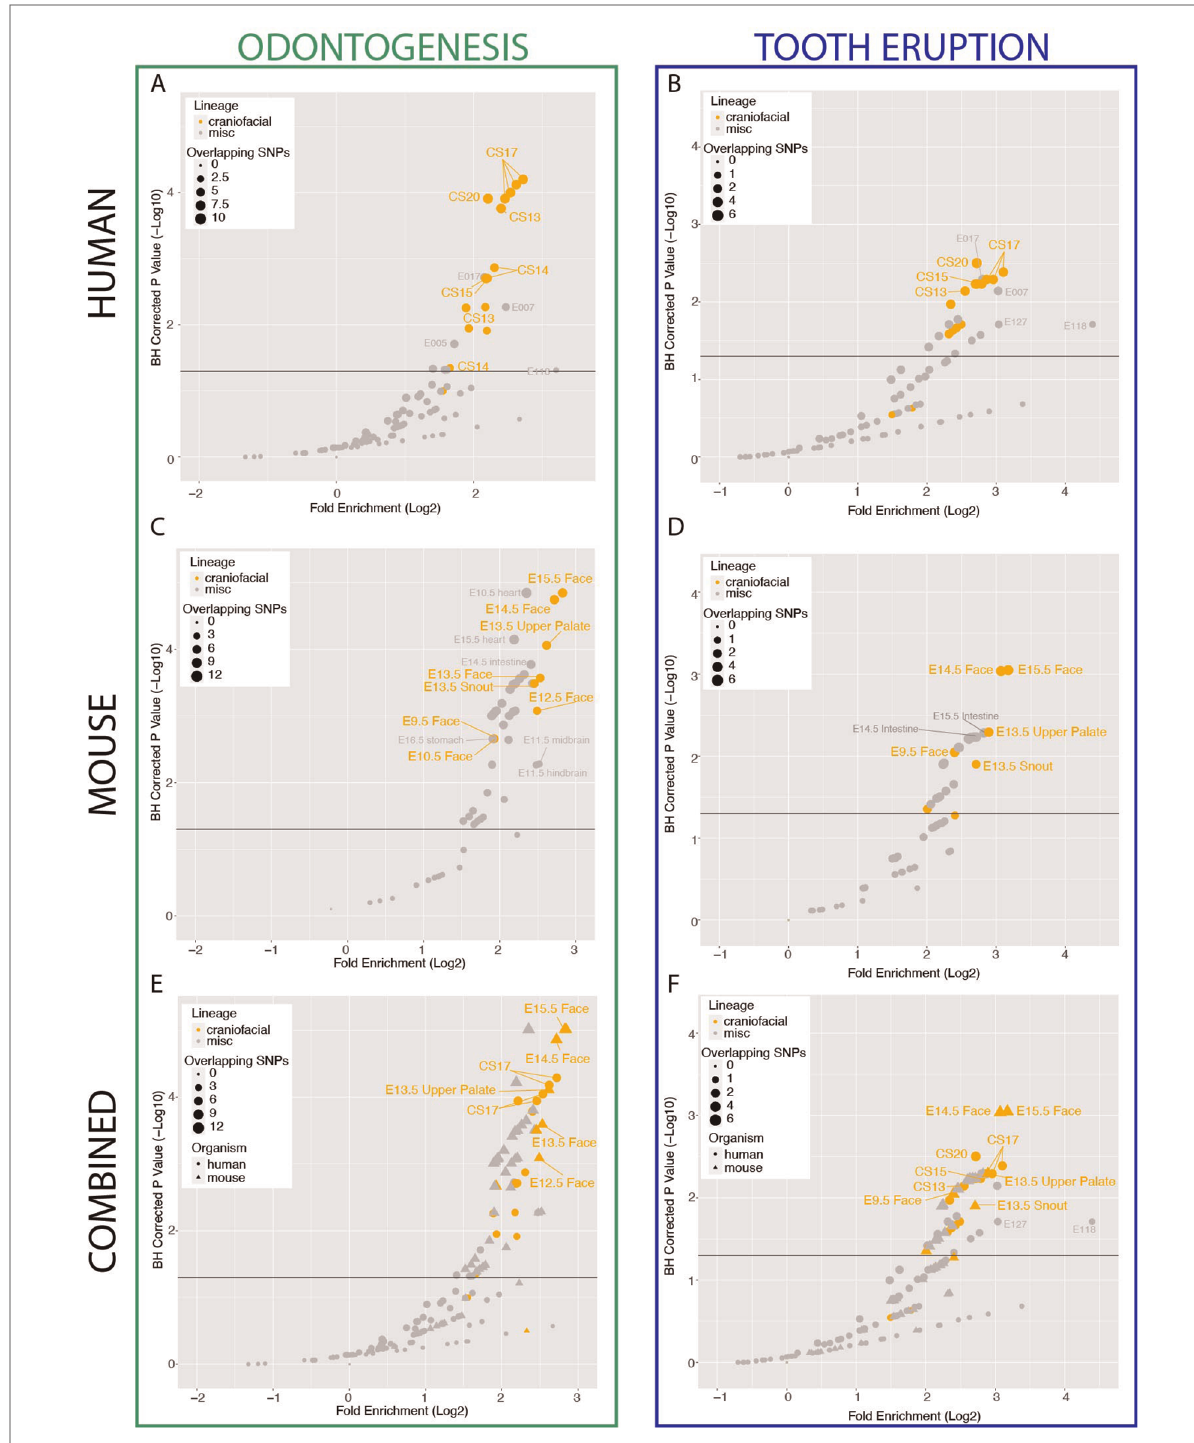
FIGURE 1 Conserved craniofacial enhancers contribute to dental development and phenotype risk. ( A ) Scatterplot of GREGOR (genomic regulatory elements and GWAS overlap algoRithm) analysis of enrichment of “ Odontogenesis ” (GO_0042476)-associated variants from GWAS Catalog in active enhancers annotated by 18 state chromatin segmentations genome-wide for samples from (40) (orange circles) and Roadmap Epigenome (grey circles). ( B ) Scatterplot of GREGOR (genomic regulatory elements and GWAS overlap algoRithm) analysis of enrichment of “ Tooth Eruption ” (GO_0044691)- associated variants from GWAS Catalog in active enhancers annotated by 18 state chromatin segmentations genome-wide for samples from (40) (orange circles) and Roadmap Epigenome (grey circles). ( C ) Analysis as in ( A ), with 18-state segmentations from Mouse ENCODE craniofacial (orange circles) and other mouse tissue samples (grey circles) (40, 51, 56). ( D ) Analysis as in ( B ), with 18-state segmentations from Mouse ENCODE craniofacial (orange circles) and other mouse tissue samples (grey circles) (40, 51, 56). ( E ) Co-projected plots of ( A ) (circles) and ( C ) (triangles), ( F ) Co-projected plots of ( B ) (circes), and ( D )